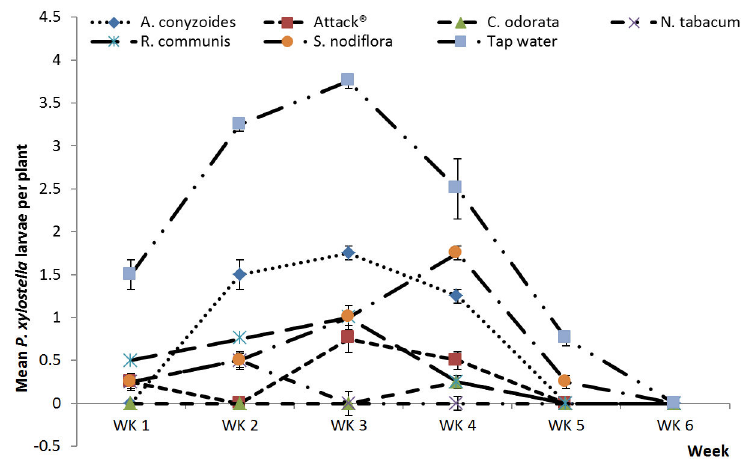
Figure 1. Plant extracts on P. xylostella , major season. Effects of plant extracts and synthetic insecticide on mean (±SE) Plutella xylostella count in a field experiment during the major rainy season, 2012 at Kumasi, Ghana. doi: